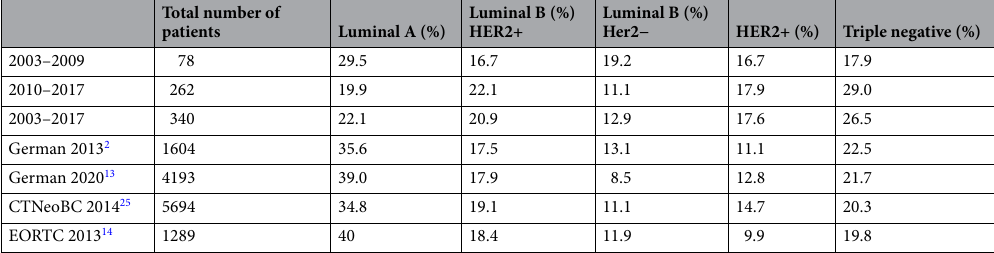
Table 8. Incidence rates of the different intrinsic subtypes in comparison with other